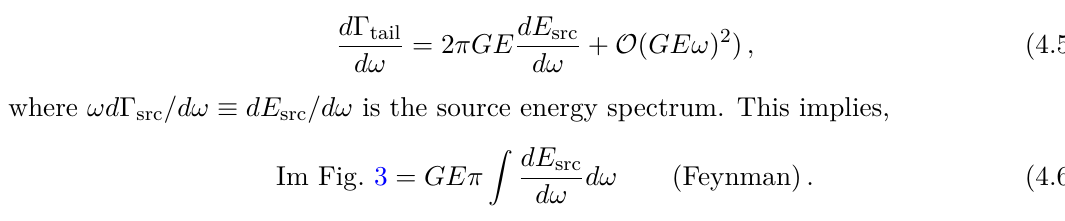
Figure 3 . Correction to the effective action due to the leading tail effect. The wavy line is the (on-shell) radiation mode while the background geometry is sourced by the total energy represented by the dashed line. The causal routing features retarded propagators, see [52] for more details. in order to match the integrated rate of graviton emission, Γ , due to the tail effect. At tail the same time, after multiplying by the phase space measure on both sides of (4.1), we